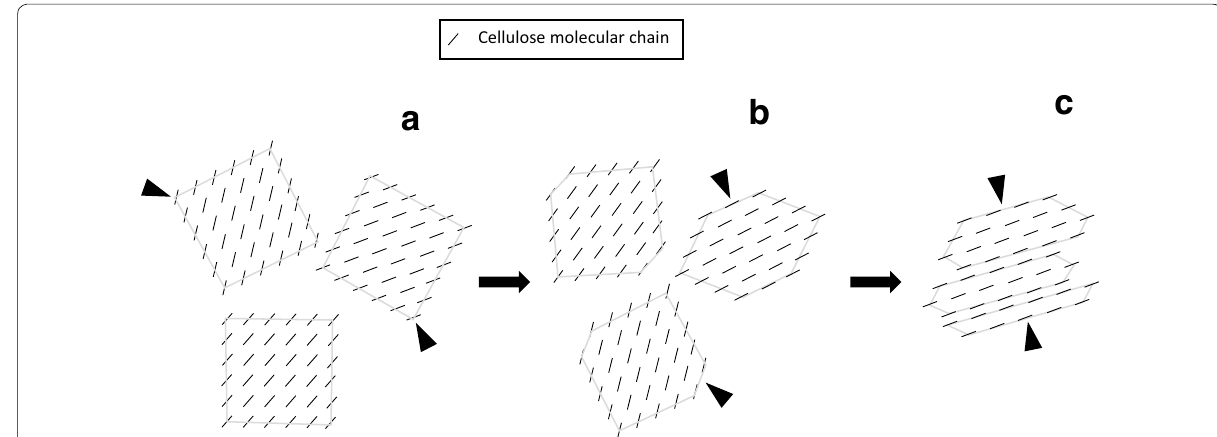
Fig. 7 Cellulose microfibril cross-section during saccharification a before saccharification, b after saccharification for 1 h, and c after the saccharification rate reached its limit. Arrowheads indicate hydrophobic planes